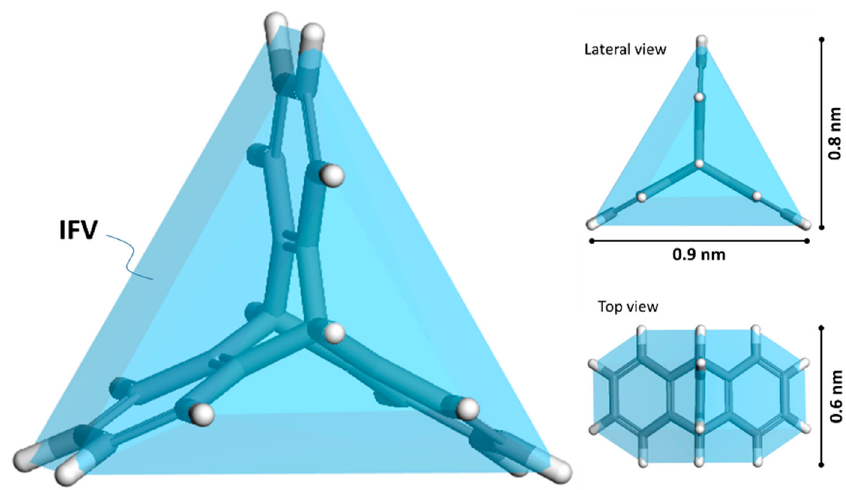
Figure 1. 3D visual of a triptycene building block (dimensions are also provided based on molecular dynamic simulation).